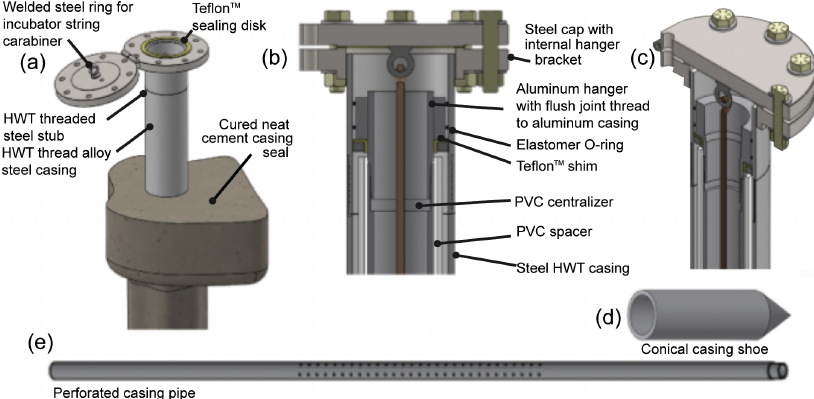
Figure 2. Borehole components of the Surtsey subsurface observatory. (a) HWT (11.43cm outer diameter) steel casing surrounds the aluminium casing to 9.54m.b.s.; (b, c) components of the wellhead. (d) Conical NQ (69mmOD) aluminium casing shoe, 25.4cm (10in.) in length. (e) Perforated NQ aluminium casing pipe, 3.66m (12ft) in length.